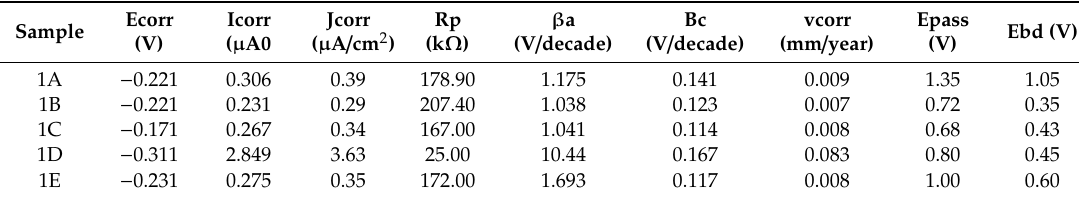
Table 5. Corrosion parameters in Ringer’s solution.